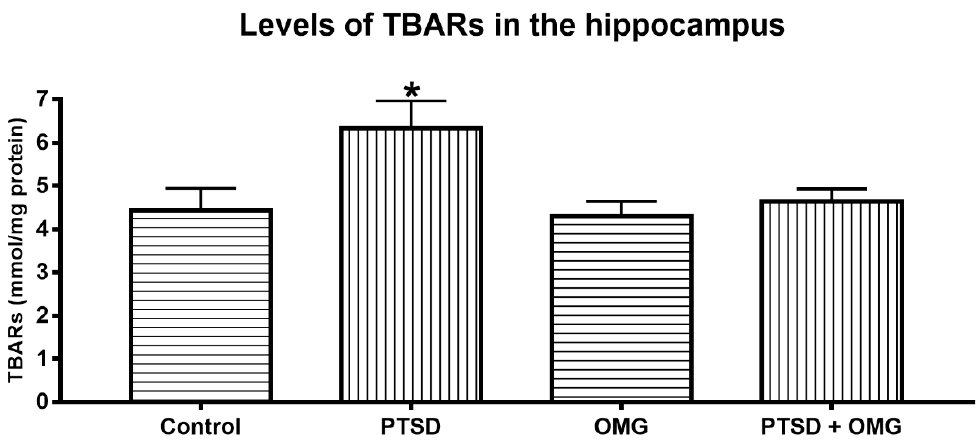
Figure 5. Changes in hippocampal thiobarbituric acid reactive substance (TBARS) levels: Levels of TBARS were significantly increased in post-traumatic stress disorder (PTSD) compared to other experimental groups. Moreover, the levels of TBARS were similar in the omega-3 treated (OMG), PTSD treated with OMG (PTSD + OMG), and control groups. * Indicate significant difference relative to control ( p < 0.05). Each point is the mean ± SEM of 15 rats.